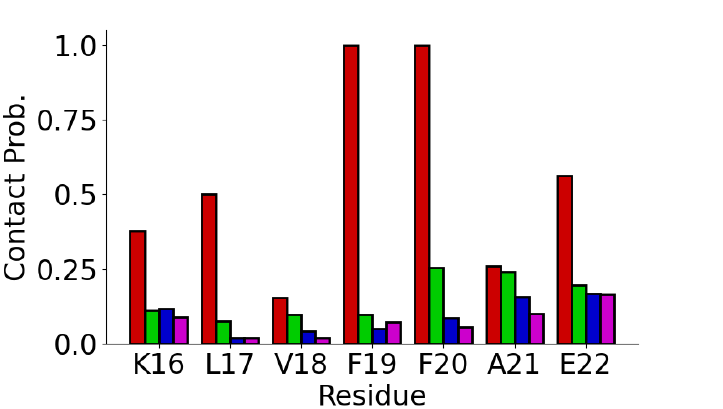
Figure 2. Residue–surface contact probabilities for A β (16–22) on Au111 (red), Au100 (green), Ag111 (blue), and Ag100 (magenta)